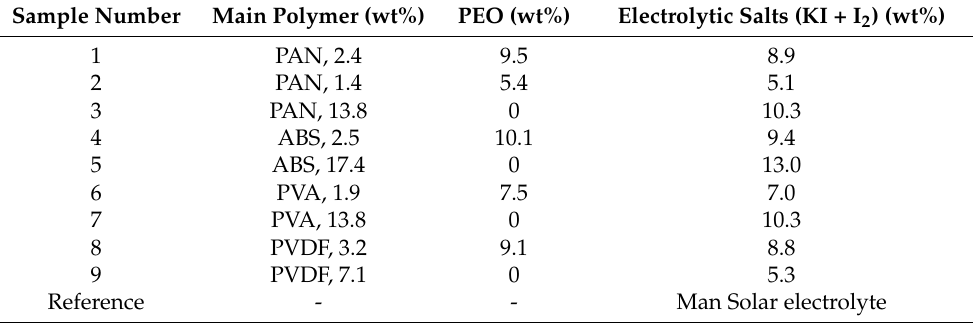
Table 1. Composition of investigated GPEs. For each sample, three DSSCs (labeled with “a”, “b” and “c”) were assembled with the corresponding